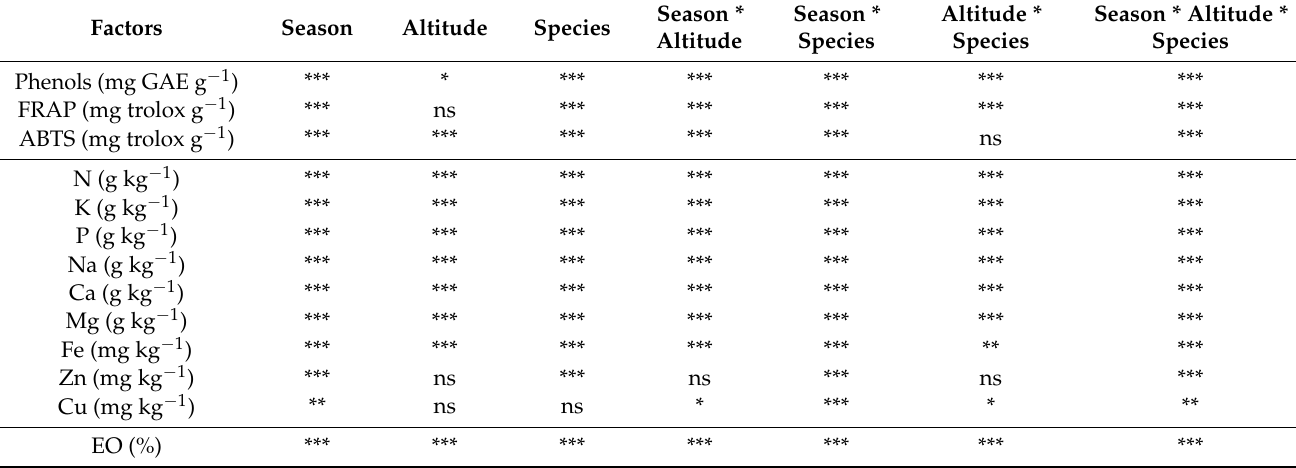
Season * Season * Altitude * Season * Altitude * Altitude Species Species Species